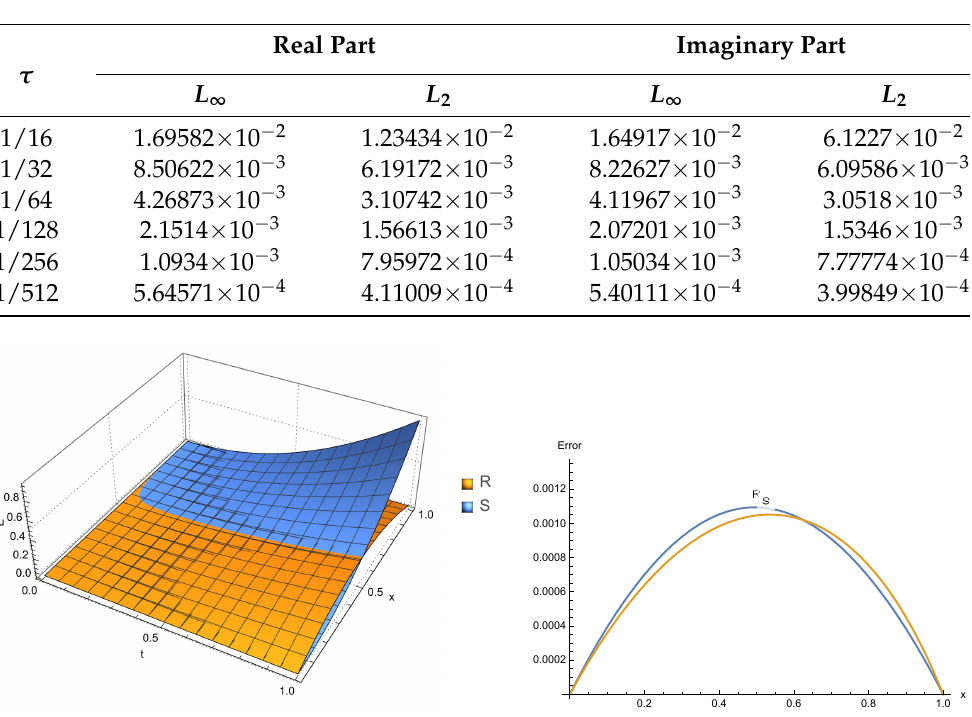
Table 9. Error norms of real and imaginary parts of Equation (2) for different choices of τ at N = 40, α = 0.1, t = 1.